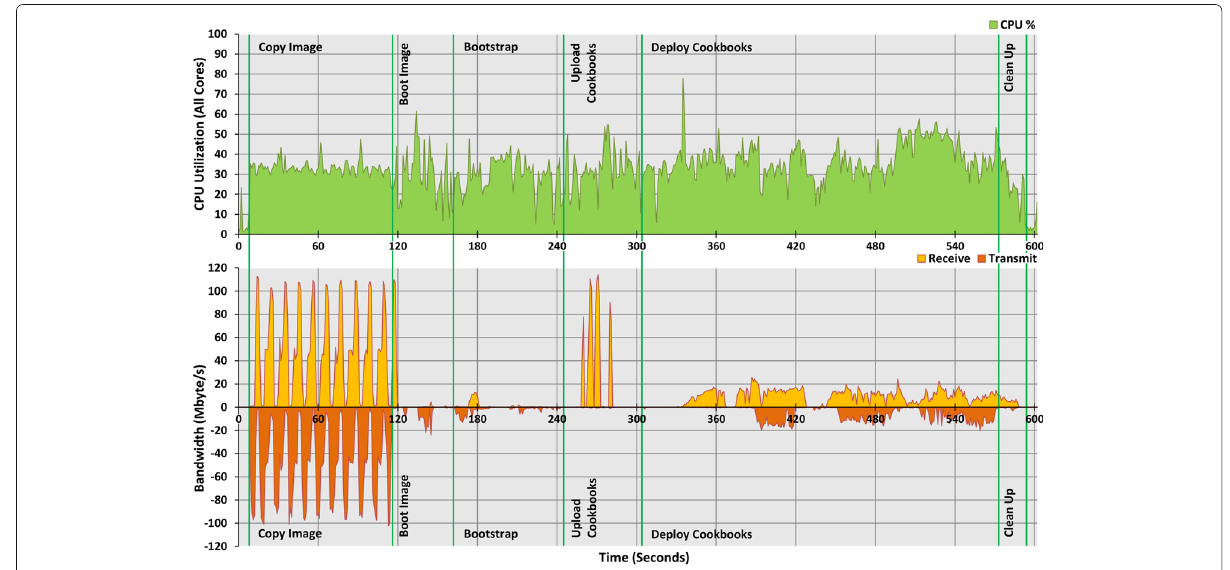
Fig. 10 VMIC resource utility for the generation of a single Windows image